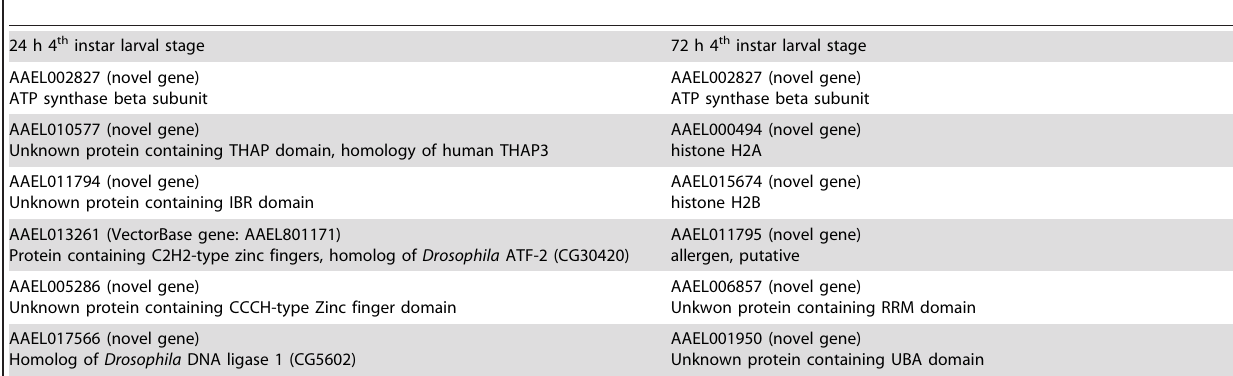
Table 1. Nuclear proteins bound to the AeSCP-2 2 1.6/ 2 1.3 kb regulatory sequence.